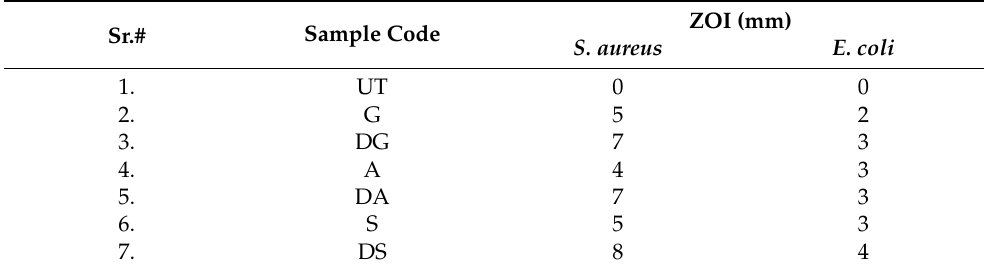
Table 6. The values of zone of inhibitions for developed samples against S. aureus and E. coli .